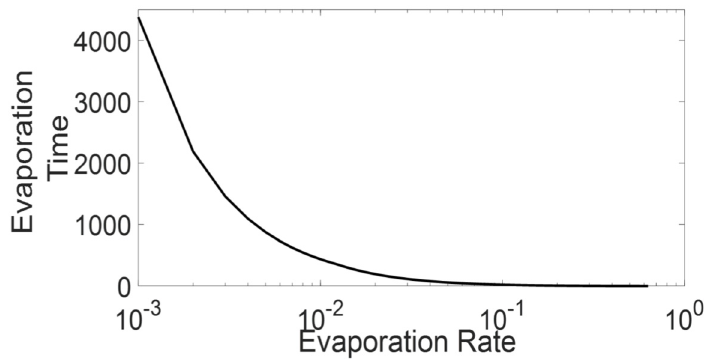
Figure 6. Approximate evaporation time required for the pheromone to decrease to the level be- low differentiable concentration ( σ x ≤ 1) in depletion scenario is plotted against corresponding evaporation rate ( r e ) (for the calculation τ = 1 p units / time step , σ sat = 80 p unit / cell ).